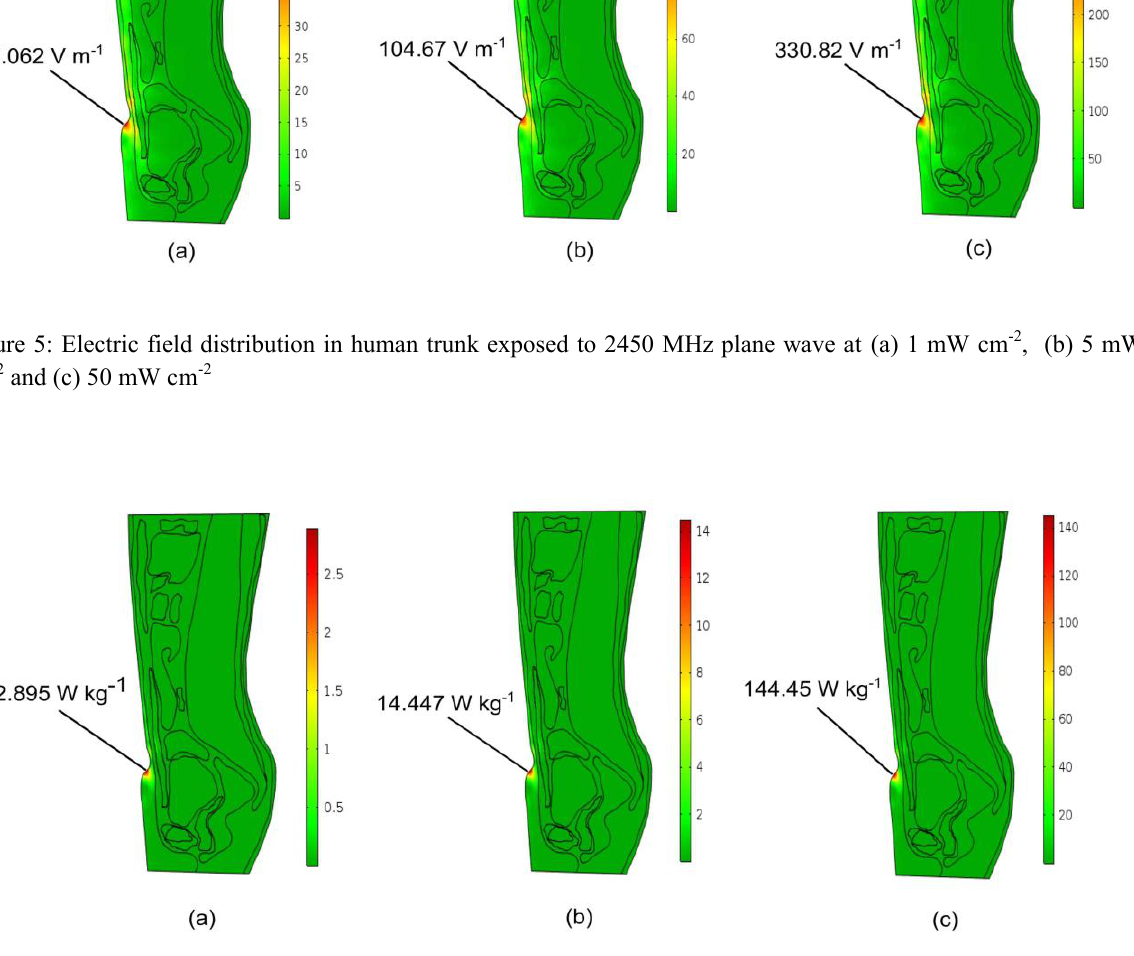
Figure 6: SAR distribution in human trunk exposed to 2450 MHz plane wave at (a) 1 mW cm -2 , (b) 5 mW cm -2 and (c) 50 mW cm